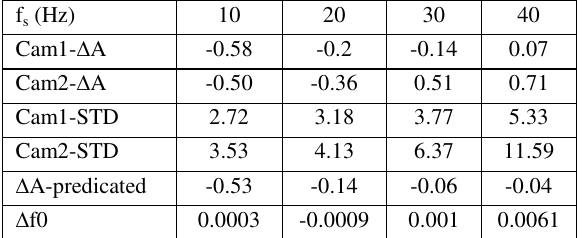
Table 2. Absolute evaluation accuracies by comparing the RC and LDS measurements and simulated amplitude